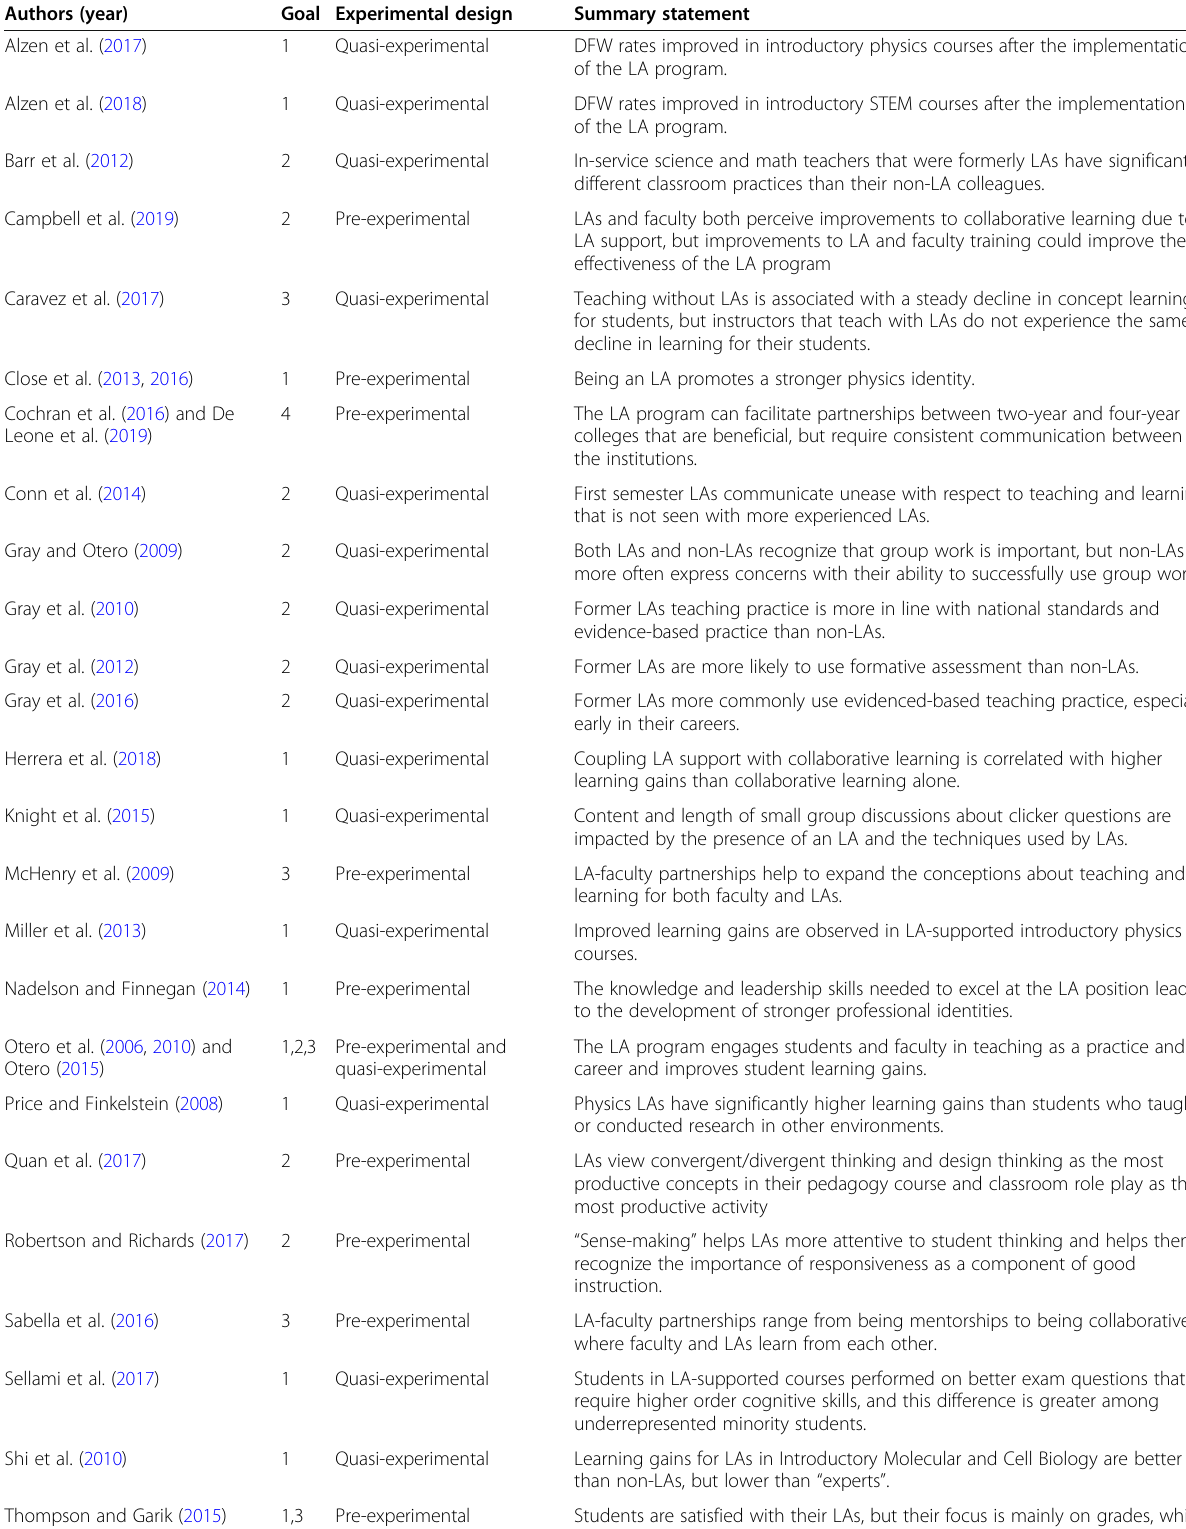
Table 1 A summary of studies referenced in this paper that assess one or more of the original goals of the LA model (see text for details of